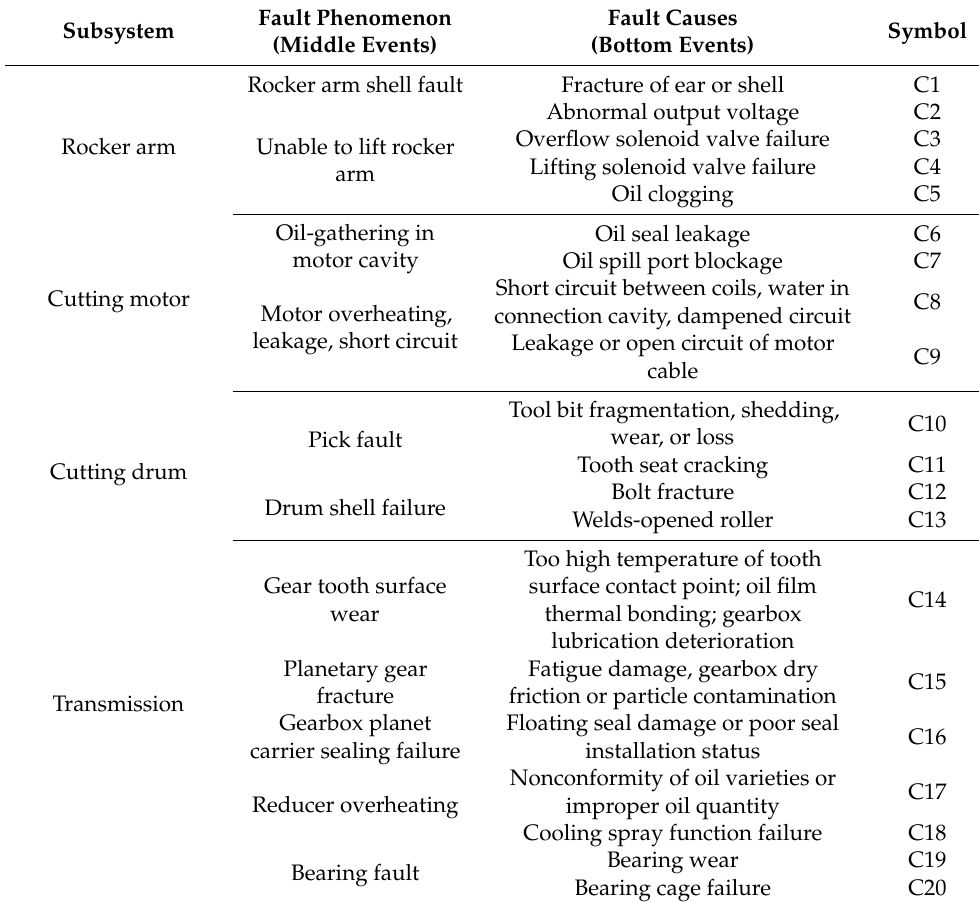
Table 2. General faults in the cutting unit of MG400/930-WD shearer. Fault Phenomenon Subsystem (Middle